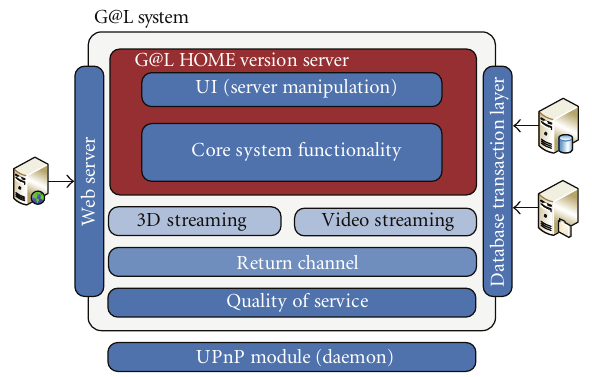
Figure 6: General server